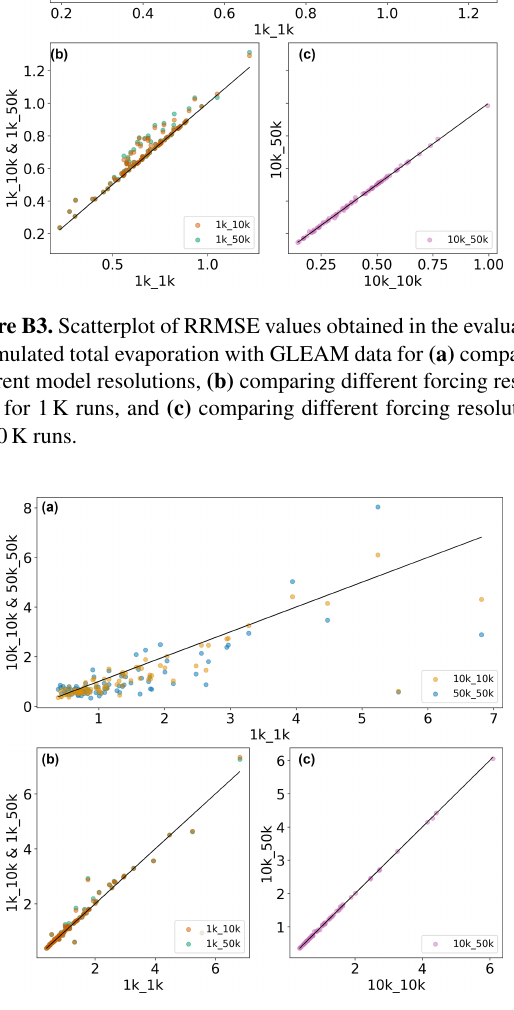
Figure B4. Scatterplot of RRMSE values obtained in the evaluation of simulated terrestrial water storage anomaly with GRACE/GRACE-FO data for (a) comparing different model res- olutions, (b) comparing different forcing resolutions for 1K runs, and (c) comparing different forcing resolutions for 10K